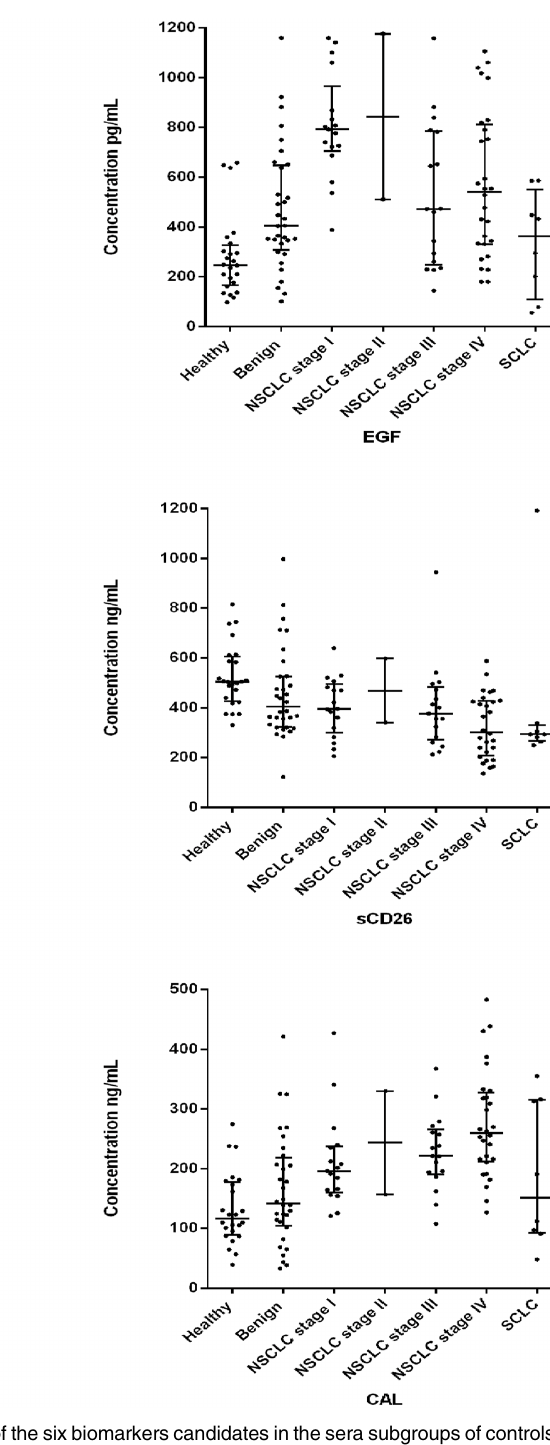
Fig 1. Box-plots of the 6 biomarkers. Box-plots of the levels of the six biomarkers candidates in the sera subgroups of controls and lung cancer patients. Horizontal lines represent median values.